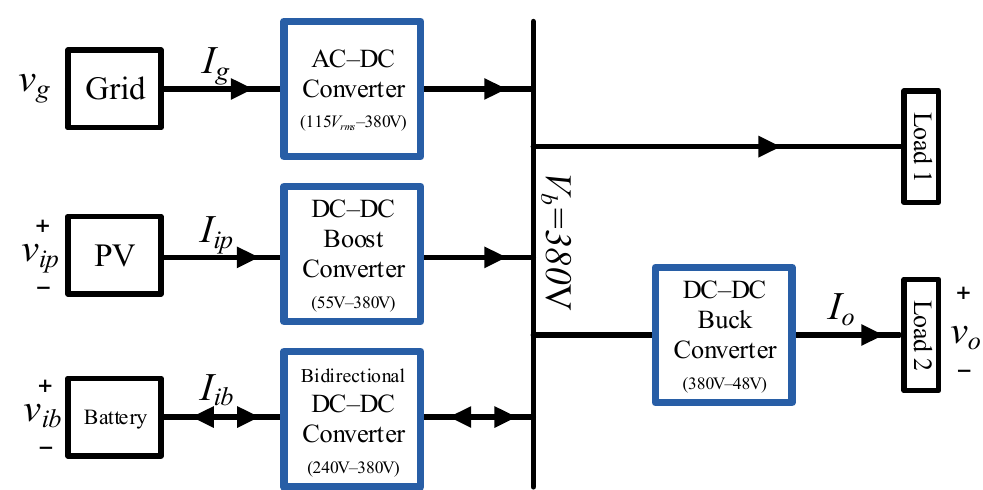
Figure 8. Block diagram of dc nanogrid-based distributed energy system.